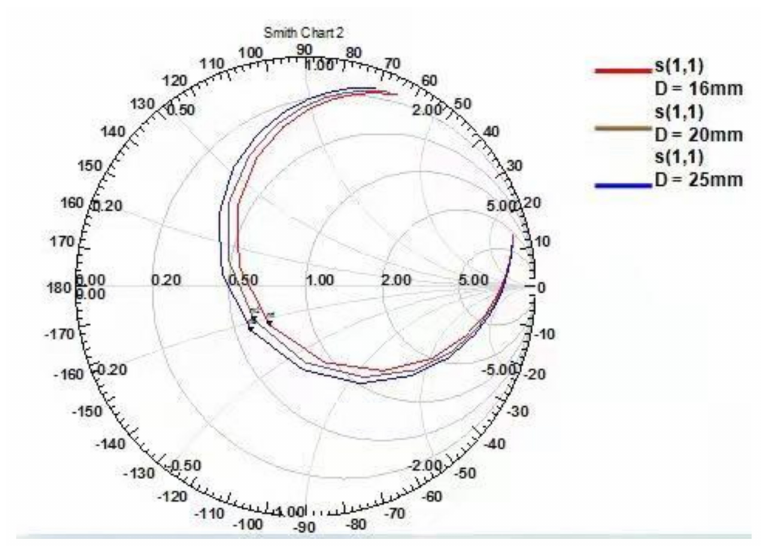
Figure 11. Smith circle charts with unit spacings of D = 16, 20, and 25